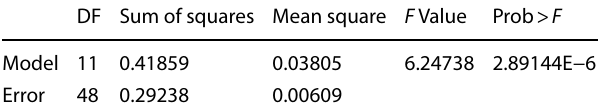
N Analysis N Missing Mean Standard